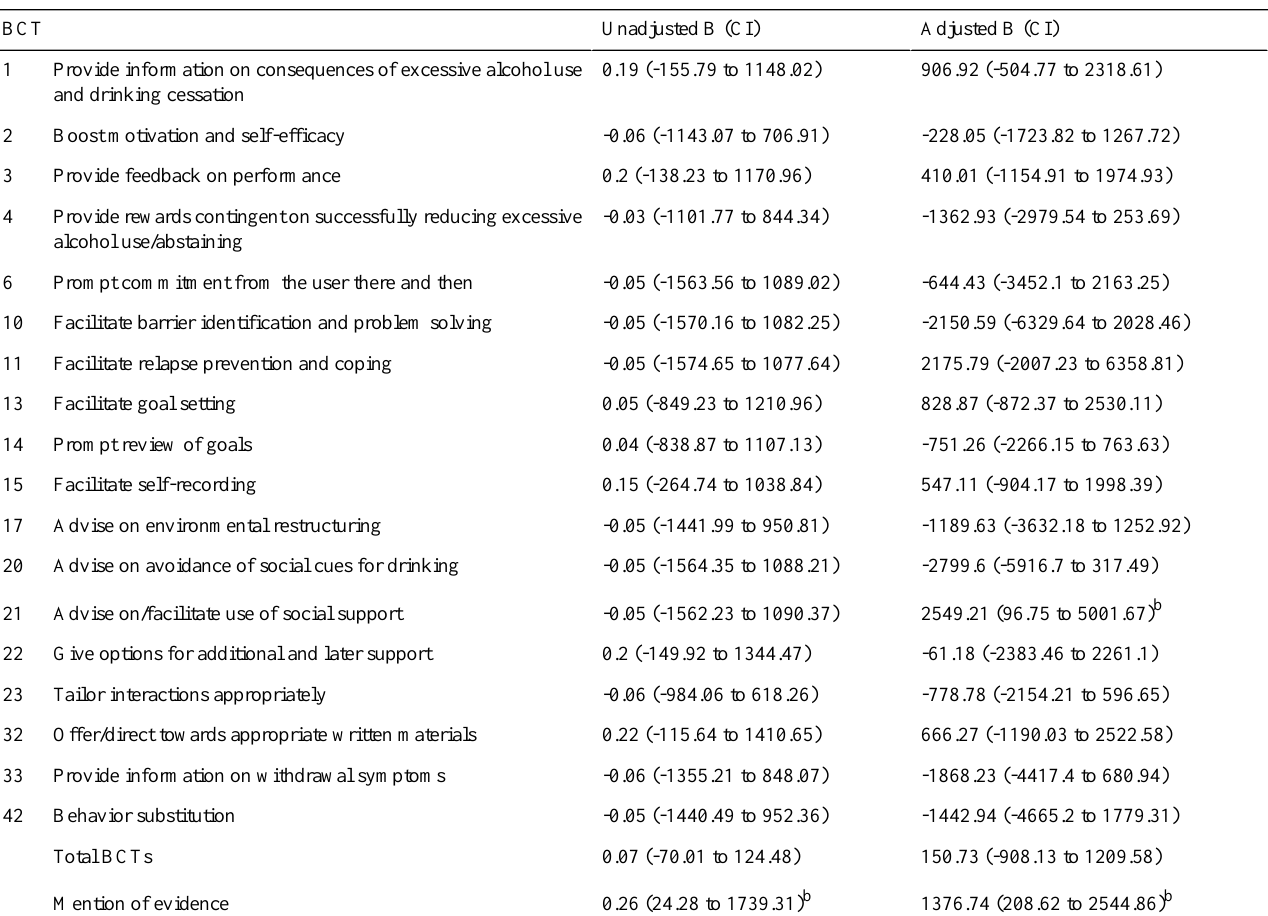
Table 3. The association between BCTs, theory/evidence with popularity (number of